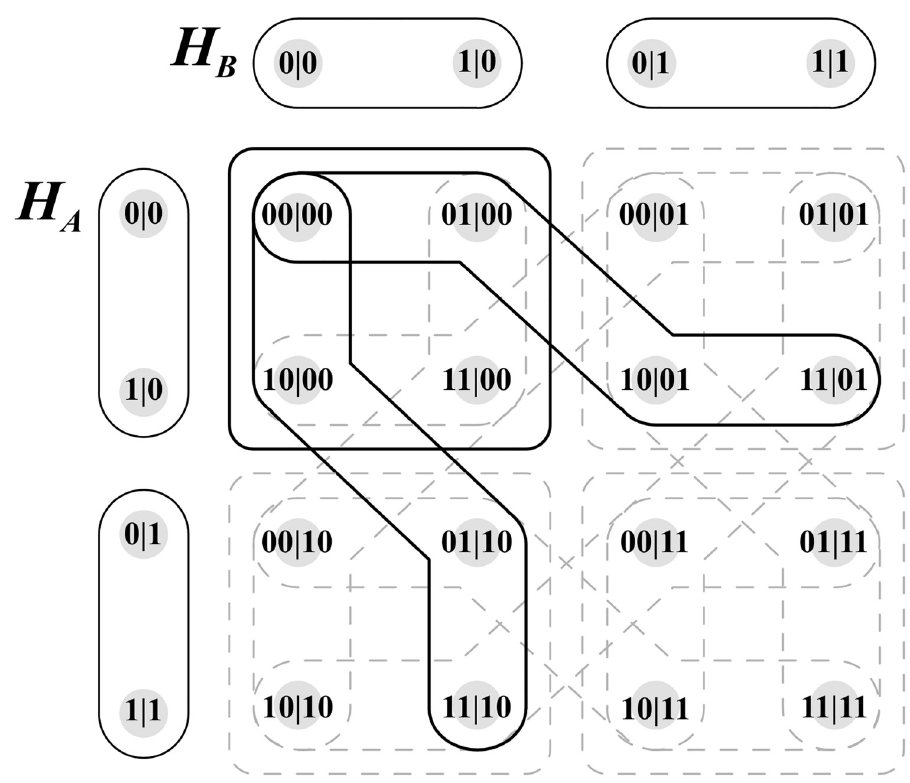
Fig 5. Single Hyperedge Of Foulis—Randall Product.